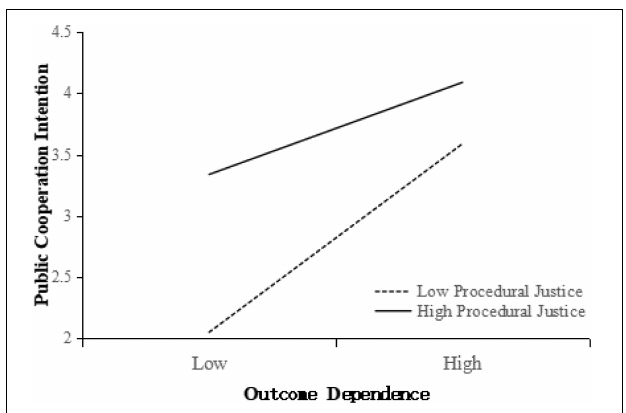
FIGURE 4 | Interaction effect of procedural justice and outcome dependence on public cooperation intention.